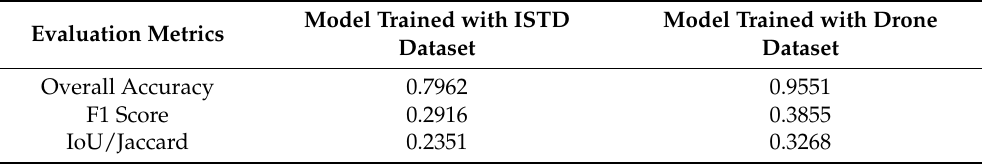
Table 4. Results of using non-drone and drone dataset